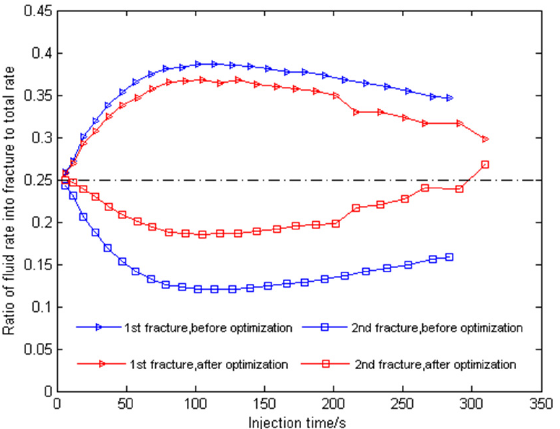
Figure 10. Comparison of ratio of fluid rate into each fracture before and after optimization of cluster spacings.